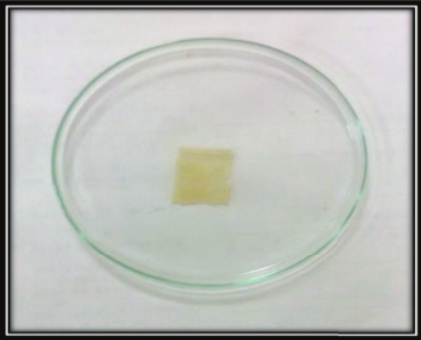
Figure 2: Sample of prepared Unani transdermal antiemetic patch.